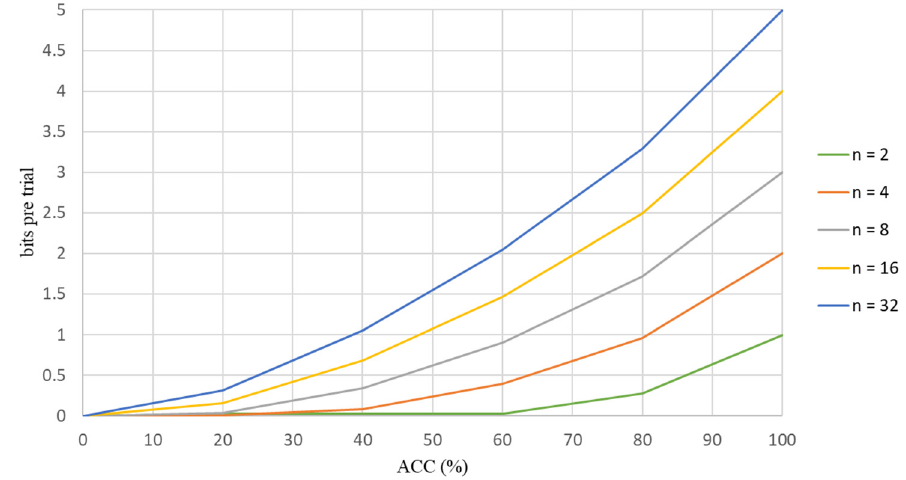
Figure 3. The information that is transferred in bits/trial for different numbers of targets.